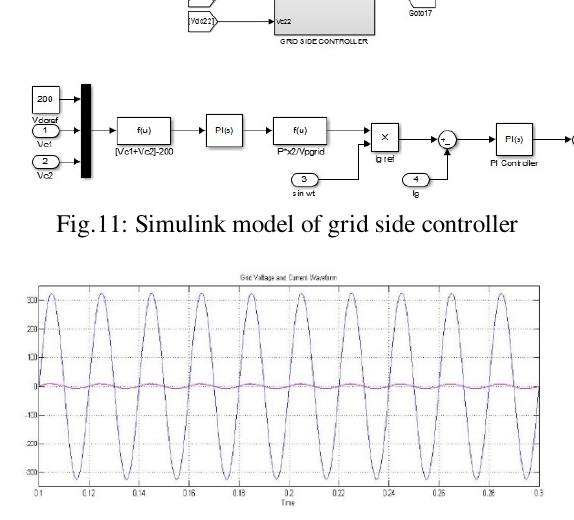
Fig.12: Grid voltage and grid current with PI controller